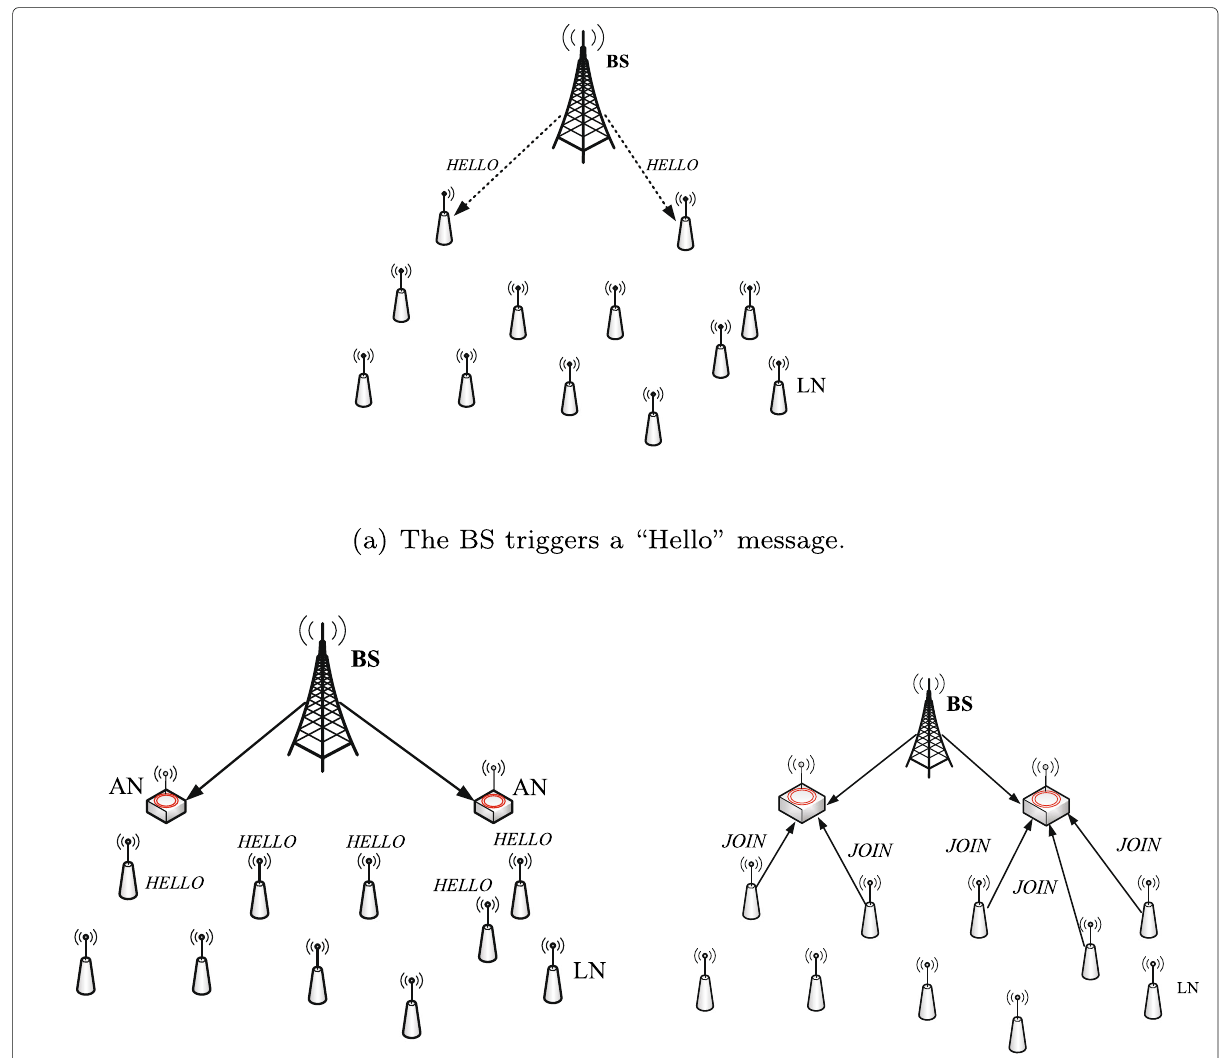
Fig. 5 The aggregation tree